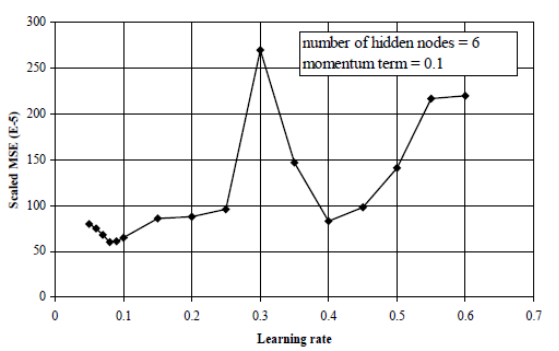
Figure 3. Influence of learning rate on ANN model performance in validation set. MSE: mean squared error.